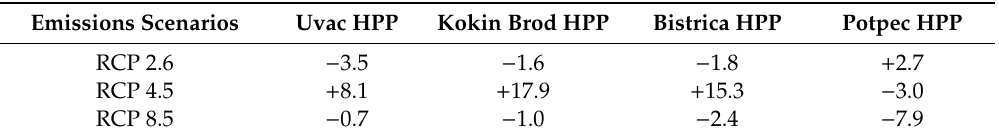
Table 3. The relative annual change (%) in the hydropower generation of the Lim water system (future period of 2006–2055 production compared to the baseline period of 1971–2000